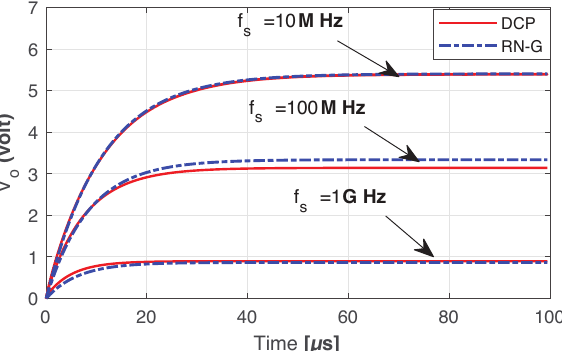
Figure 15. Time-domain SPICE simulation of the output voltage at different frequencies for the switching DCP and the